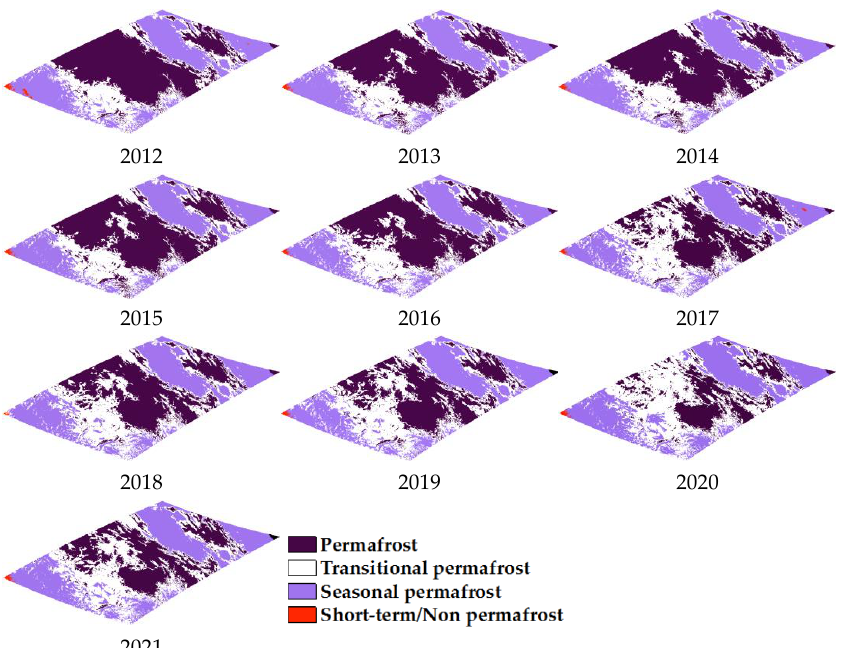
Figure 8. Permafrost distributions classified into four classes (permafrost, transitional permafrost, seasonal permafrost, and short-term/non-permafrost) for each year from 2012 to 2021.